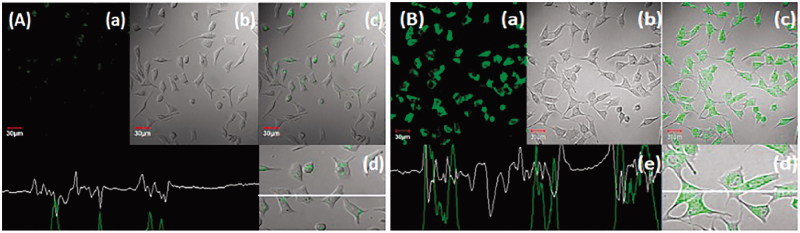
Uptake of (A) free coumarin-6 (C-6) and (B) C-6 loaded GA-nano-lipid carrier, upon incubation at 1 µg/mL for 2 h. In all the images, (a) images under the green fluorescence channel; (b) corresponding differential interface contrast images of HepG2 cells. (c) Superimposition of figure (a) and figure (b). (d, e) In all, the images show horizontal line series analysis of fluorescence along the white line.